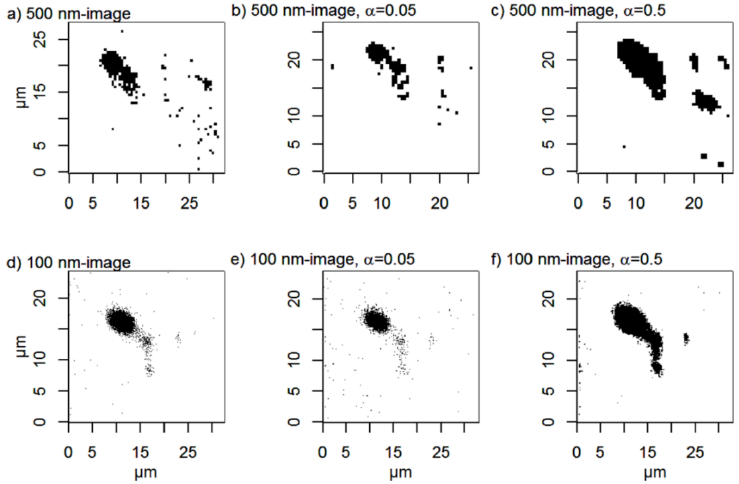
Figure 11. Threshold images of the score map for PC2 of ( a ) 500 nm image; ( b ) super-resolution 500 nm image, α = 0.05; ( c ) super-resolution 500 nm image, α = 0.5; ( d ) 100 nm image; ( e ) super-resolution 100 nm image, α = 0.05; ( f ) super-resolution 100 nm image, α = 0.5. The arrows point at a particle agglomerate that is difficult to detect without applying super-resolution. Threshold values are calculated with the “triangle method”